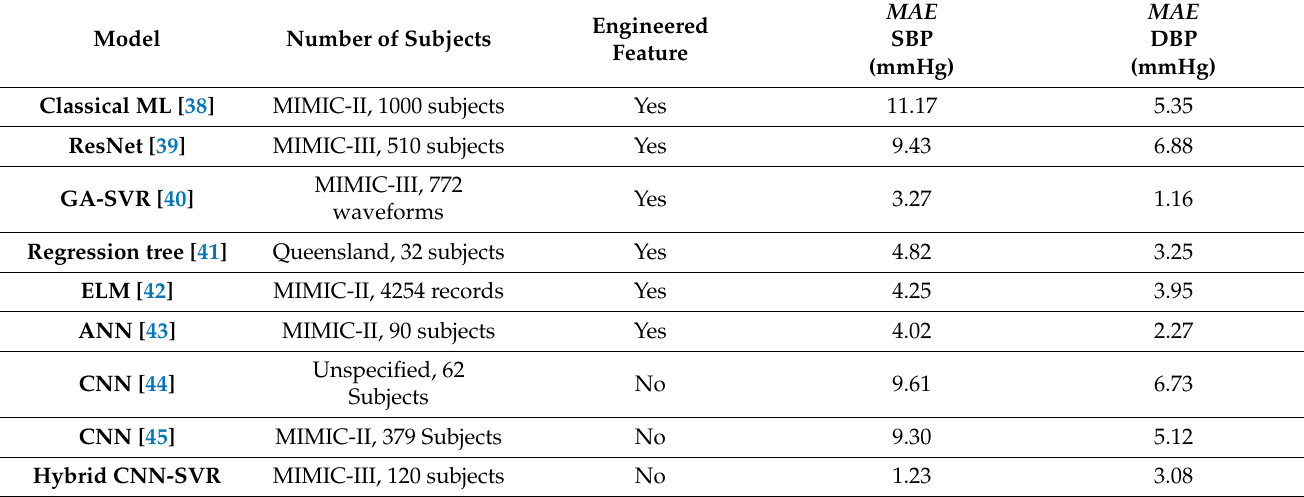
Table 2. Comparison of hybrid CNN-SVR BP model performance with other works in terms of methodology, database, use of engineered features, and estimation